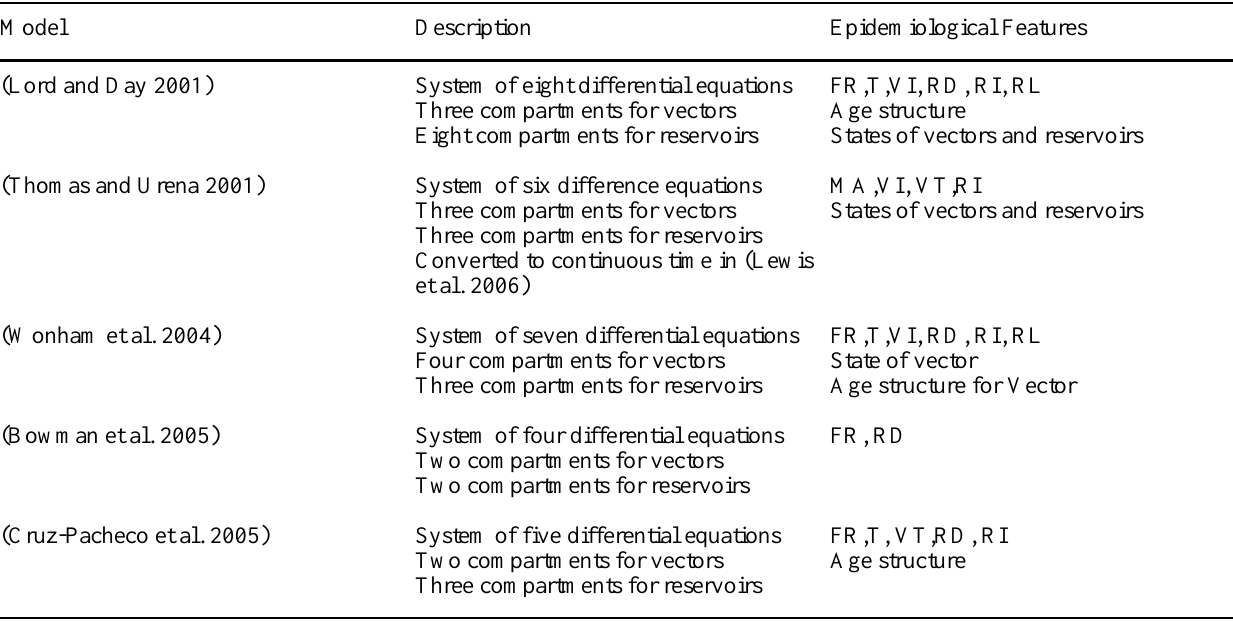
Table 1. The five dynamic single-season models for West Nile virus along with their epidemiological features (FR = reservoir frequency dependence, T = transmission probabilities, VI = viral incubation period, VT = vertical transmission, RD = reservoir death from virus, RI = reservoir loss of immunity).